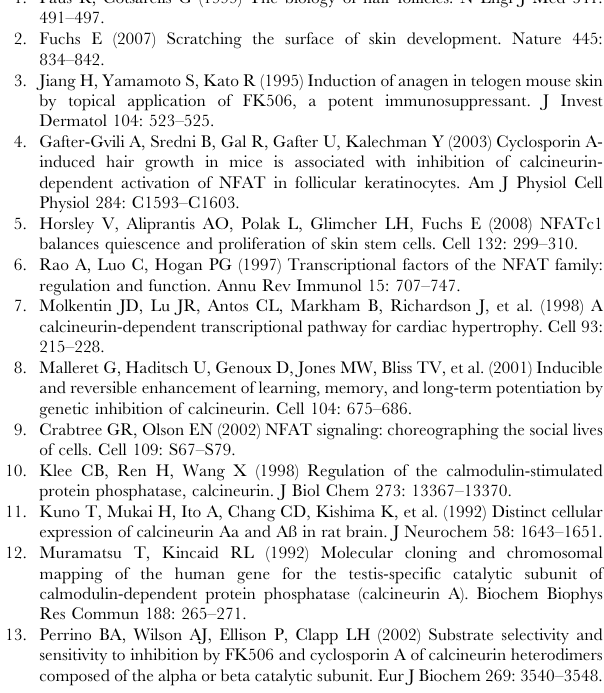
Figure S8 Cyclosporin A reduces cyclin G2 expression in hair follicles through NFATc2 inhibition. (A) Time-scale of the hair cycle in male Wister rats. The intensity of gray shading indicates the rate of proliferation of follicular keratinocytes as described in Fig. 3a. (B–E) NFATc2 and cyclin G2 localization in anagen stage hair follicles of a control rat. Arrows indicate nuclear